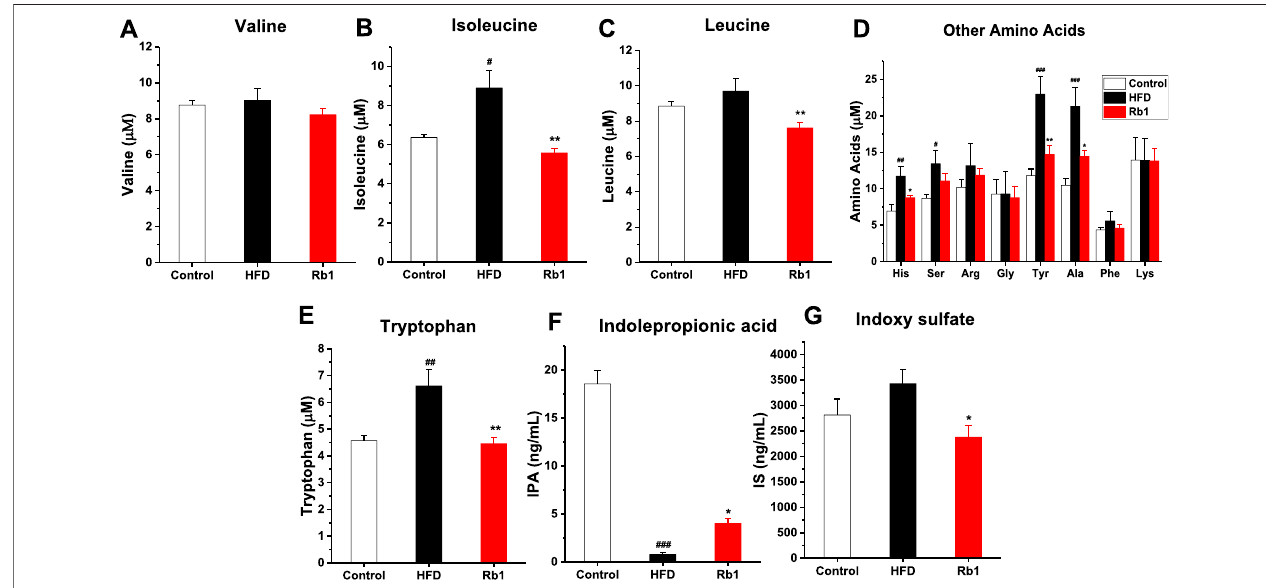
FIGURE 6 | The effects of Rb1 supplementation on amino acids metabolism. (A) valine (Val) (B) isoleucine (Iso) (C) leucine (Leu) (D) Other amino acids, histidine (His); serine (Ser); arginine (Arg); glycine (Gly); tyrosine (Tyr); alanine (Ala); phenylalanine (Phe); lysine (Lys) (E) tryptophan (Trp) (F) indolepropionic acid (IPA) (G) indoxyl sulfate(IS) inserum.Thedataareexpressed asthemean ± SEM;n (cid:1) 6;one-wayanalysisofvariancewithTukey ’ sposthoctest. # p < 0.05, ## p < 0.01, and ### p < 0.001 for NC vs HFD; * p < 0.05, ** p < 0.01 for Rb1 vs